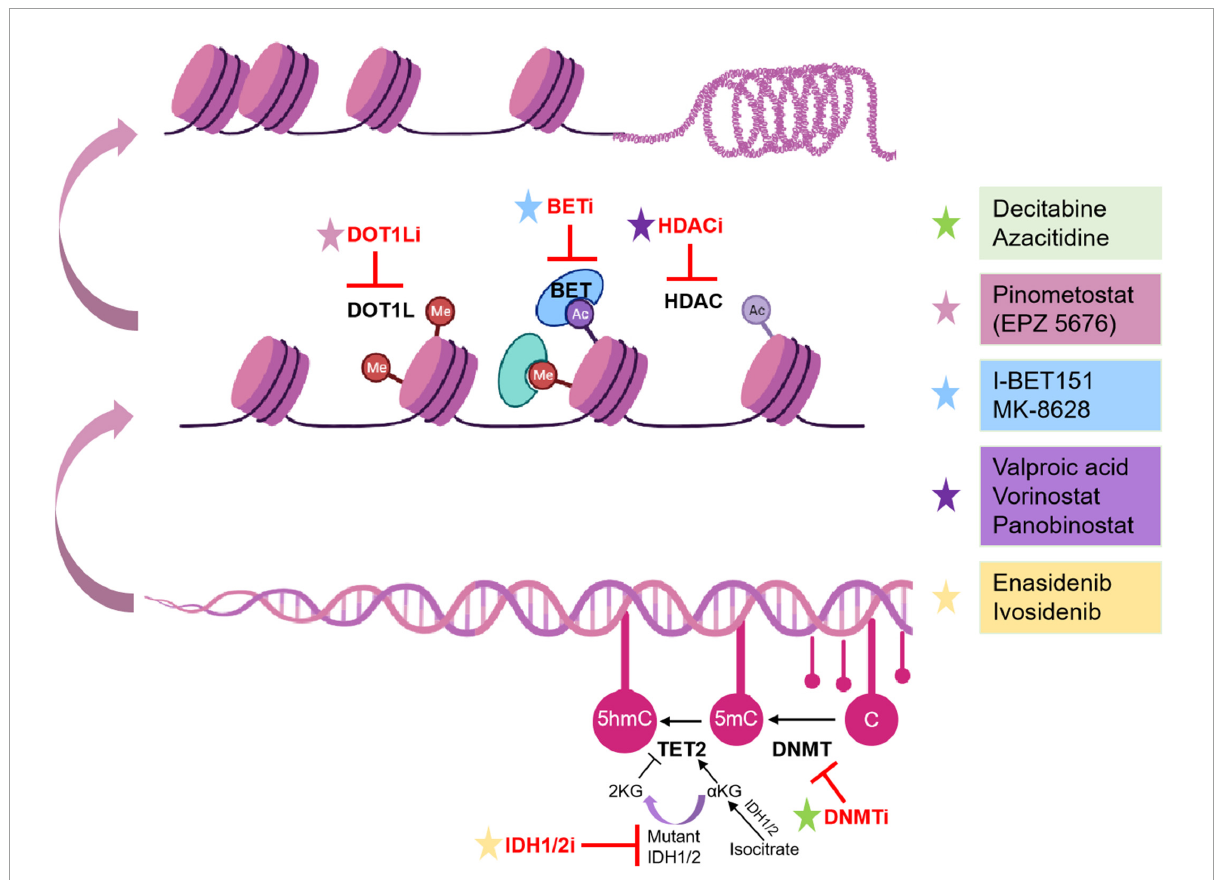
FIGURE1 Epigenetic inhibitors and mechanisms in pediatric AML. Epigenetic inhibitors are highlighted in red. C, cytosine; Ac,